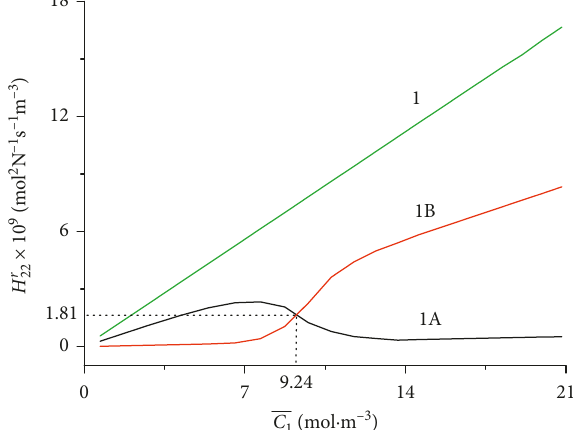
f ( C 1 , C 2 22 (cid:31) f ( C 1 , 22 (cid:31)